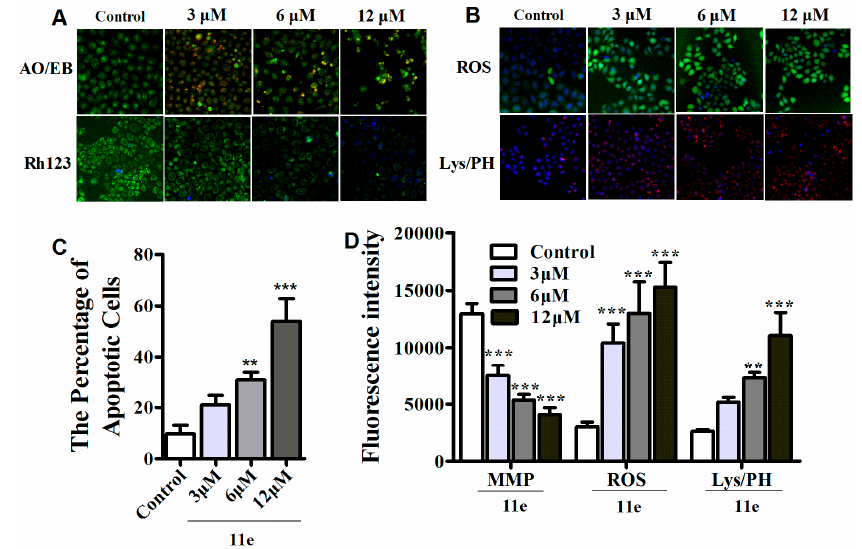
Figure 3. The apoptosis and MMP (mitochondrial membrane potential), ROS (reactive oxygen species) and lysosomal mass/pH (Lys/PH) were investigated in HepG2 cells in vitro. ( A ) The cellular morphous, MMP were detected with AO/EB, Rh123/Hoechst33342 staining using HCS in HepG2 cells; ( B ) ROS, lysosomal mass/pH were detected by HCS using DCFH-DA and Lyso-Tracker Red staining respectively; ( C ) 11e induced apoptotic cells at different concentrations (3, 6, 12 μ M) assessed by HCS using AO/EB staining after 48 h treatment in HepG2 cells ( n = 3, x ± SD, ** p < 0.01, *** p < 0.001); ( D ) Impacts of 11e at different concentrations (3, 6, 12 μ M) on MMP, ROS, lysosomal mass/pH, detected by HCS using Rh123, DCFH-DA, and Lyso-Tracker Red staining respectively after 48 h treatment in HepG2 cells. Each sample is the mean of three independent experiments. ( n = 3, x ± SD, ** p < 0.01, *** p < 0.001).